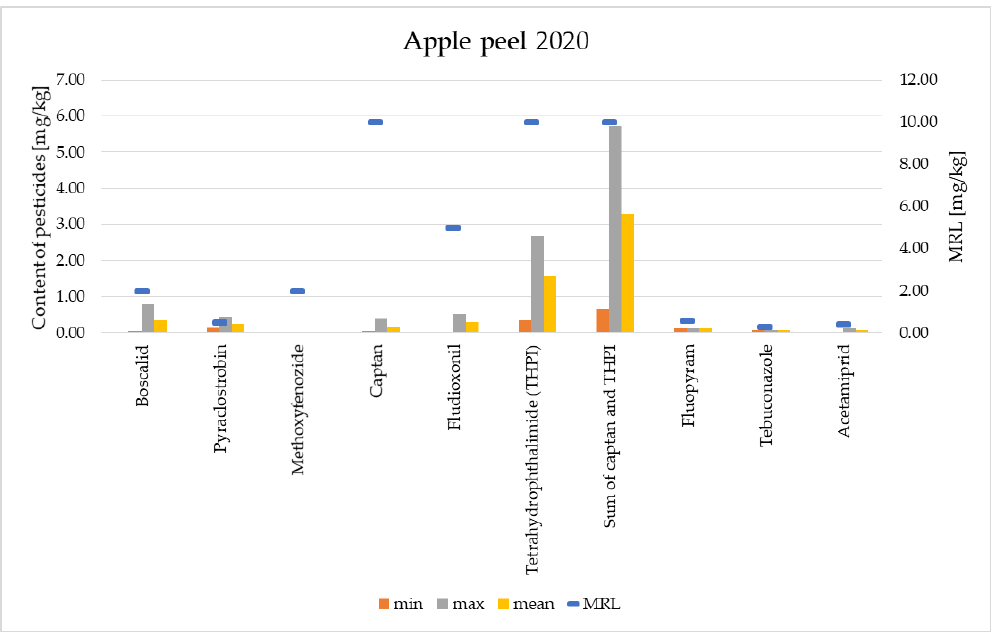
Figure 9. Content of pesticides in samples of flesh of apples from the harvest of 2012.